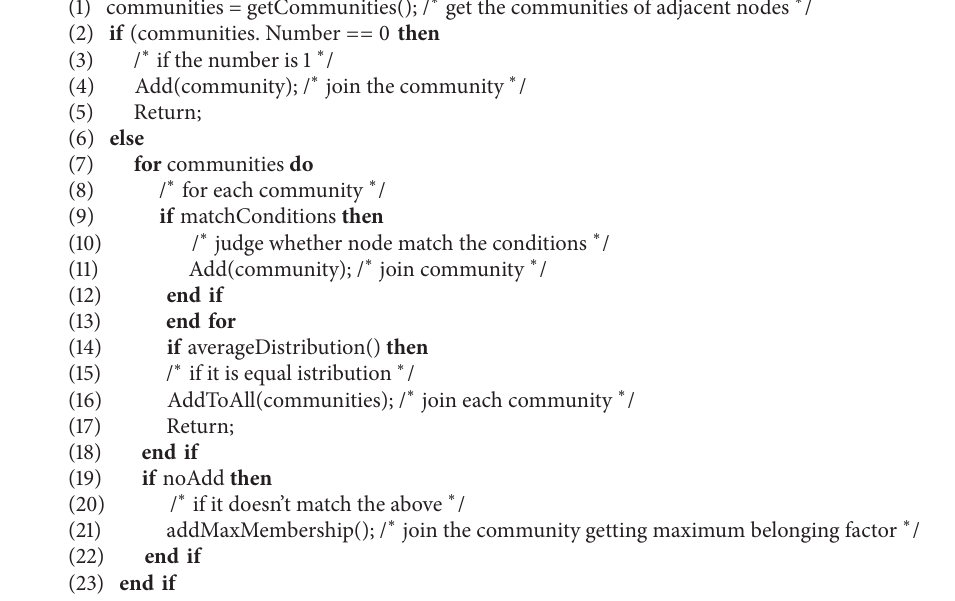
Algorithm 1: The redistribution algorithm for unallocated